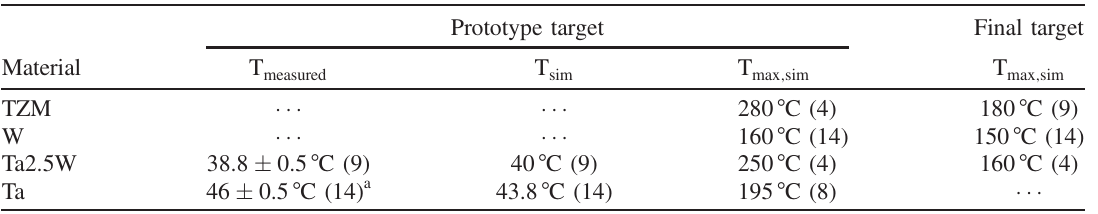
TABLE V. Maximum temperatures measured by the sensors (T ) and corresponding expected temperature measured according to the FEM simulations (T ). Pt100 accuracy computed as (cid:2)ð 0 ; 3 þ 0 ; 005 (cid:3) T Þ °C. Estimation of the sim ) and comparison with maximum temperatures reached in the different target materials at 3 . 75 × 10 12 ppp (T max ; sim the maximum temperatures foreseen for the final target under operational conditions. The target block where the maximum temperature is measured/expected is shown in parenthesis. The current design of the BDF final target does not include pure tantalum as cladding material.